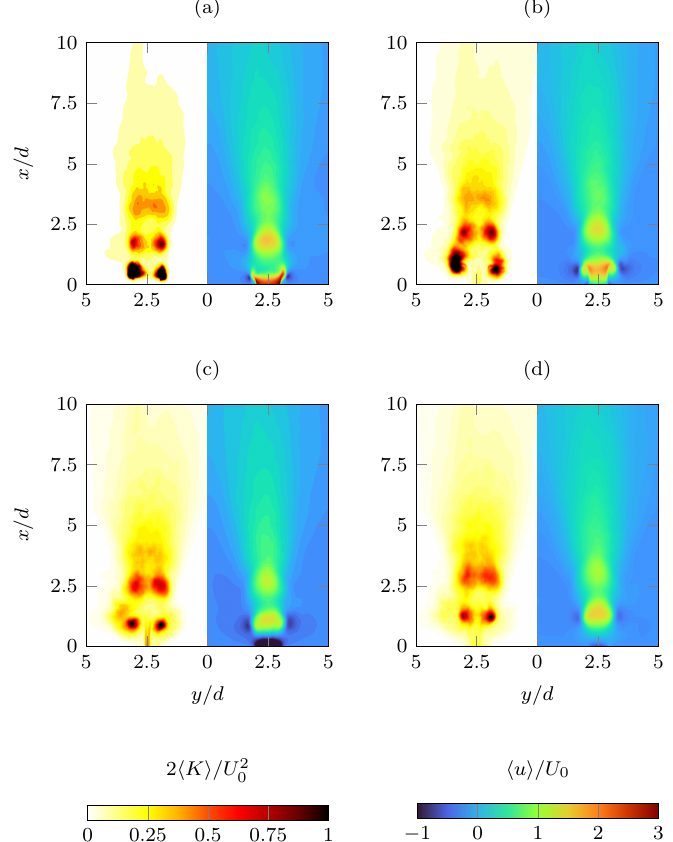
K (left half of each plot) (cid:104) (cid:105) u (right half of each plot): z = 0, s o / d = 2.5, (cid:104) (cid:105)